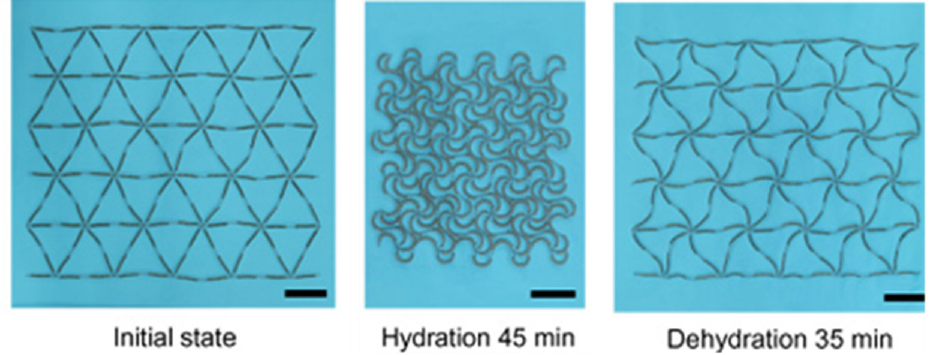
Figure 13. Lattice comprised of hydrogel-composite meta-units, with successive stages of hydration displayed. Here, the scale bar length equates to 5 mm. The initial state is shown at ambient conditions, before immersion in water for 45 min, followed by dehydration via a drying oven set at 75 °C for 35 min [36].